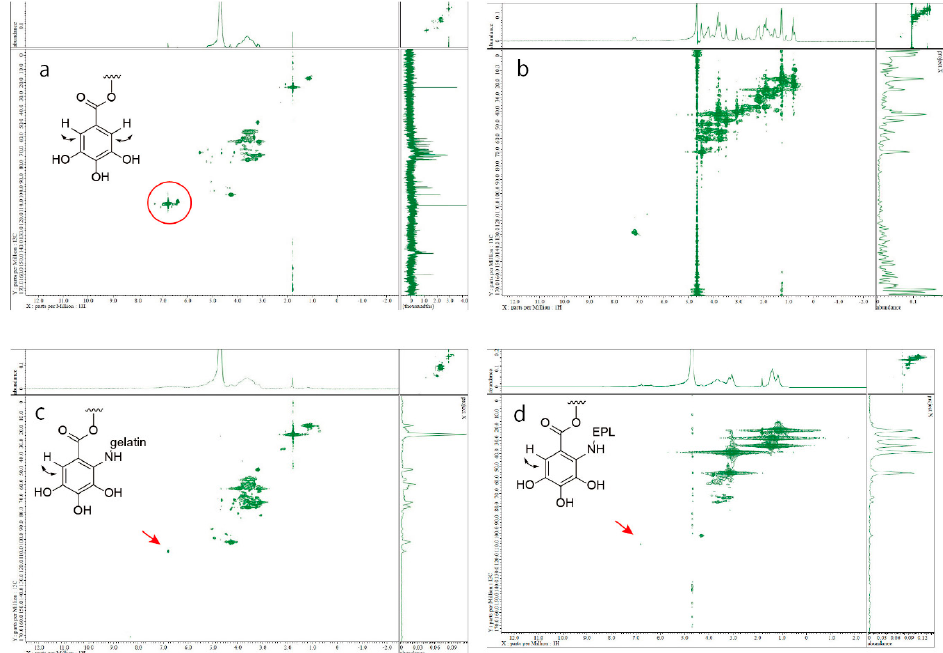
Figure 3. HMQC spectra of Tannin C ( a ), gelatin ( b ), gelatin–Tannin C ( c ), and EPL–Tannin C ( d ).